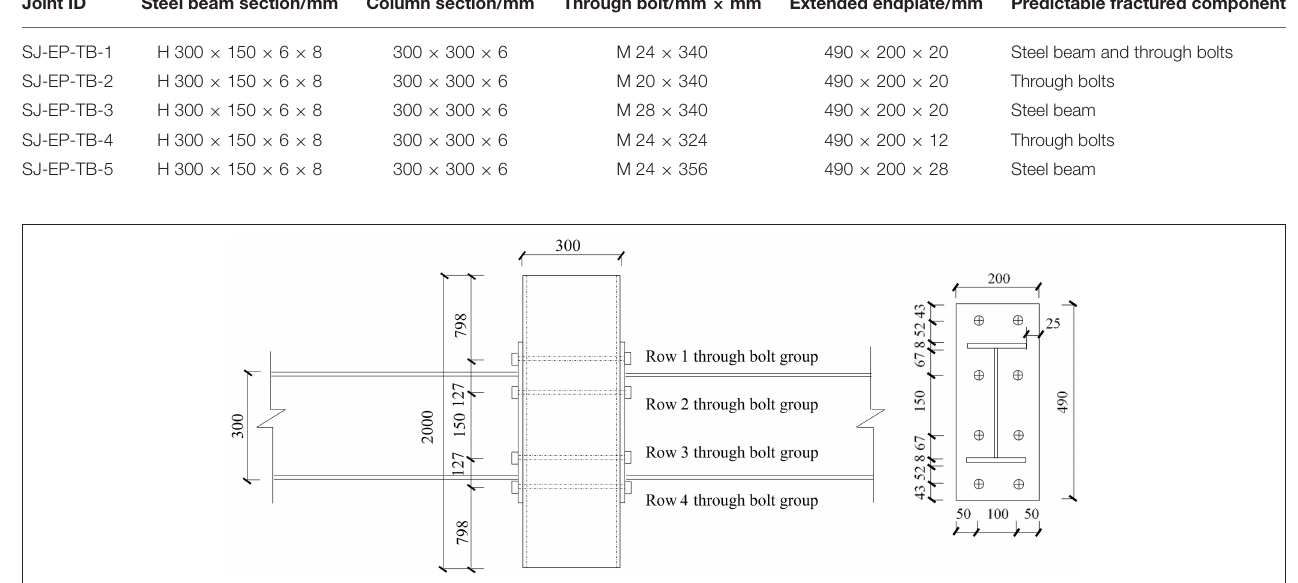
FIGURE 8 | Construction details of joints.